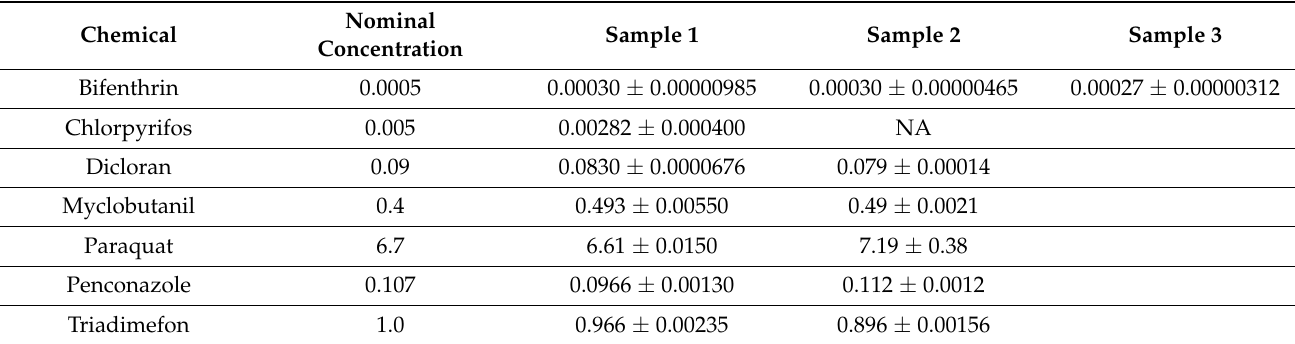
Table 2. Analytical data from the middle concentration of each compound. All concentrations expressed as mg/L (nominal). NA = not available due to sample loss during shipping. All values are reported as the mean ± standard error. Recoveries